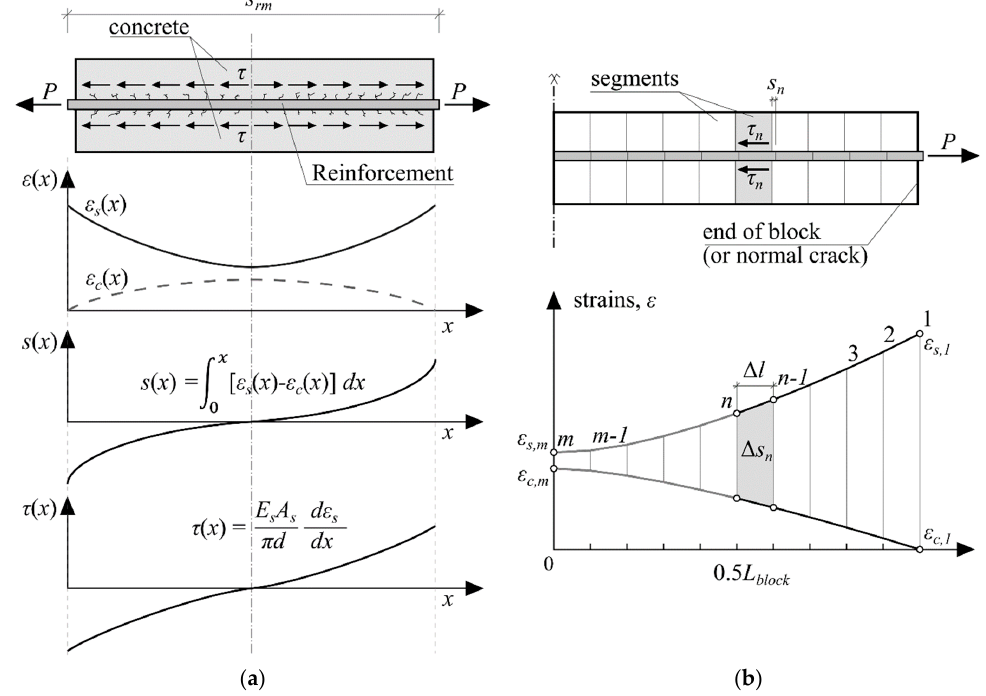
Figure 5. Stress transfer approach explained through ( a ) strain, slip, and bond stress variations along the reinforced concrete prism; ( b ) numerical iterative procedure as defined for half an element.